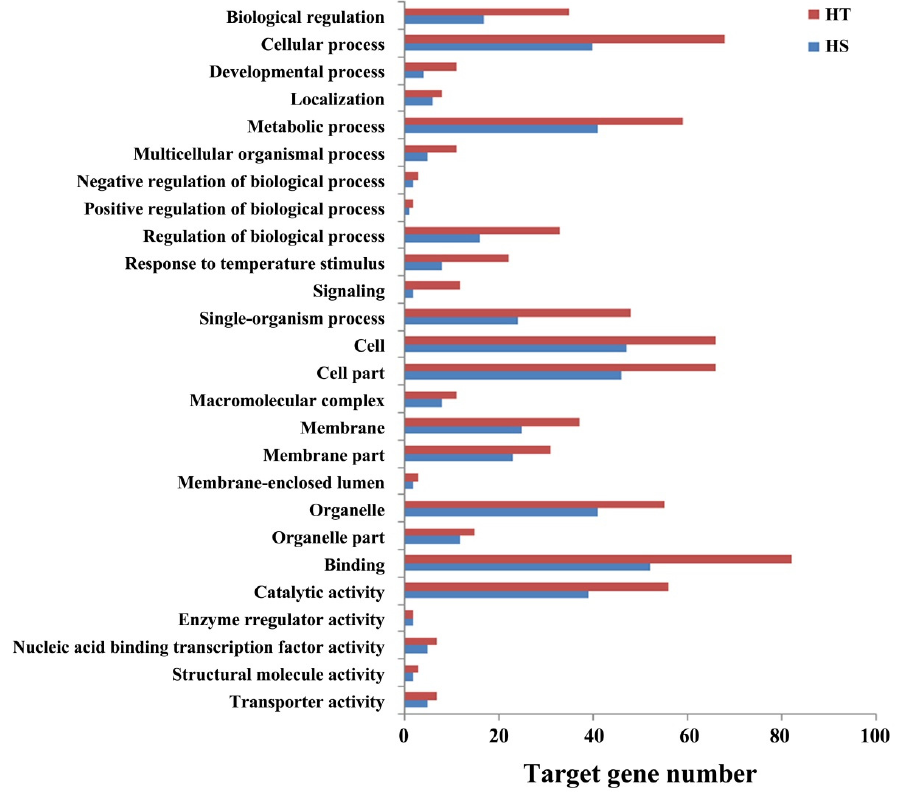
Figure 4. Gene Ontology (GO) annotation for target genes of heat responsive microRNAs in the heat-tolerant (HT) and heat-sensitive (HS) genotypes of flowering Chinese cabbage.